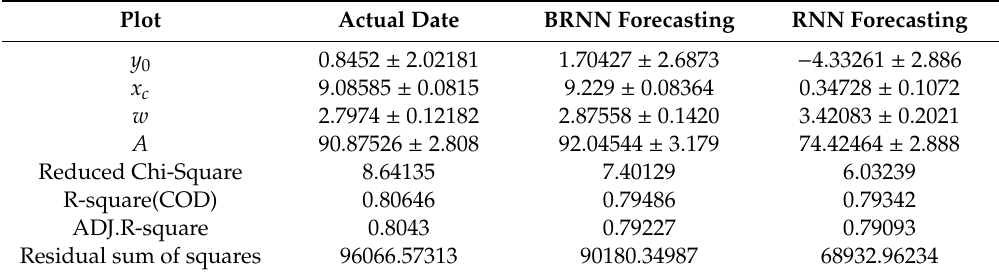
Table 2. Data table of fitting results.